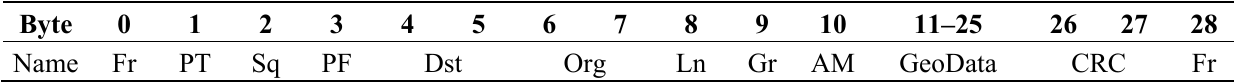
Table 2. Geo-broadcast header. Fr, header start and finish byte; PT, protocol type;